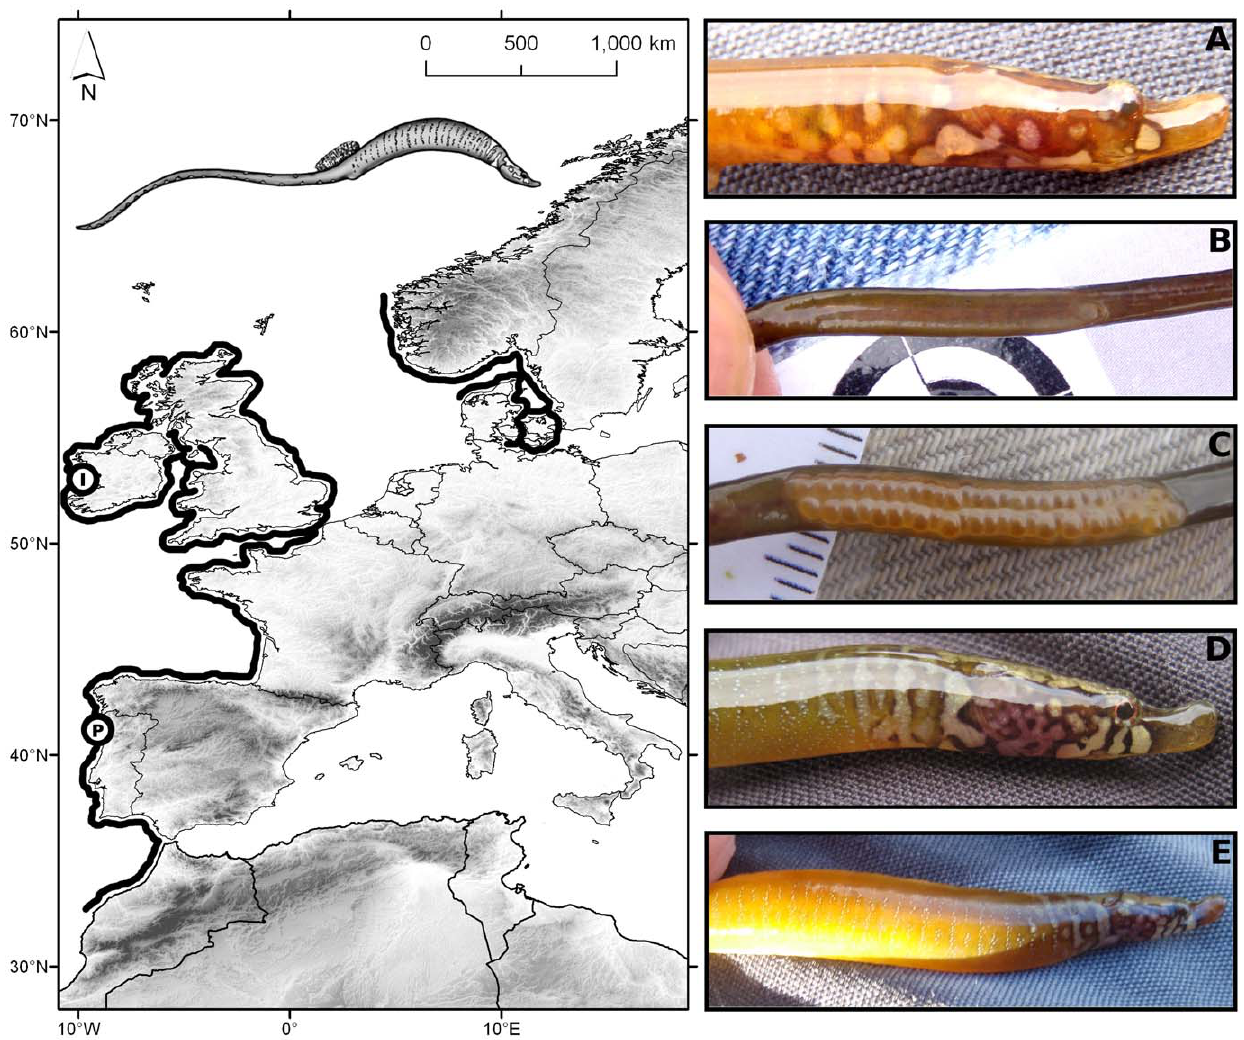
Figure 2. The biogeographical distribution of Nerophislumbriciformis , according to Dawson (1986). Circles indicate the location of the two sampled populations (P= Portugal, Viana do Castelo, 41 u 70 9 N 8 u 85 9 W; I= Ireland, Galway Bay, 53 u 15’ N 9 u 10 9 W). Pictures of adult worm pipefish are also presented (A- Male’s facial pigmentation; B- Male’s empty brooding surface; C- Male’s brooding surface with eggs; D- Female’s facial pigmentation; E- Female 9 s keel-like structure on the abdominal